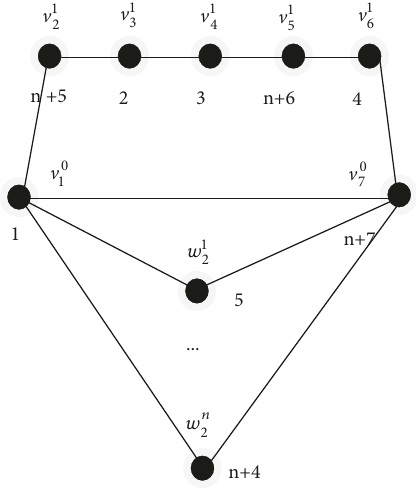
Figure 6: Bijective function 𝑔 1 (𝑥) .